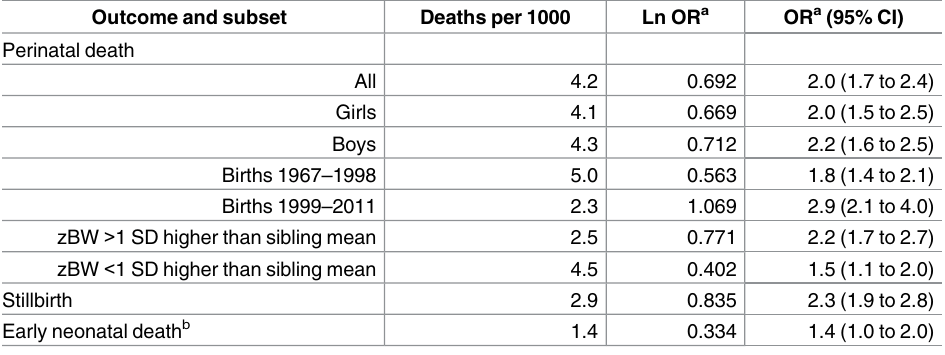
Stillbirth Early neonatal death